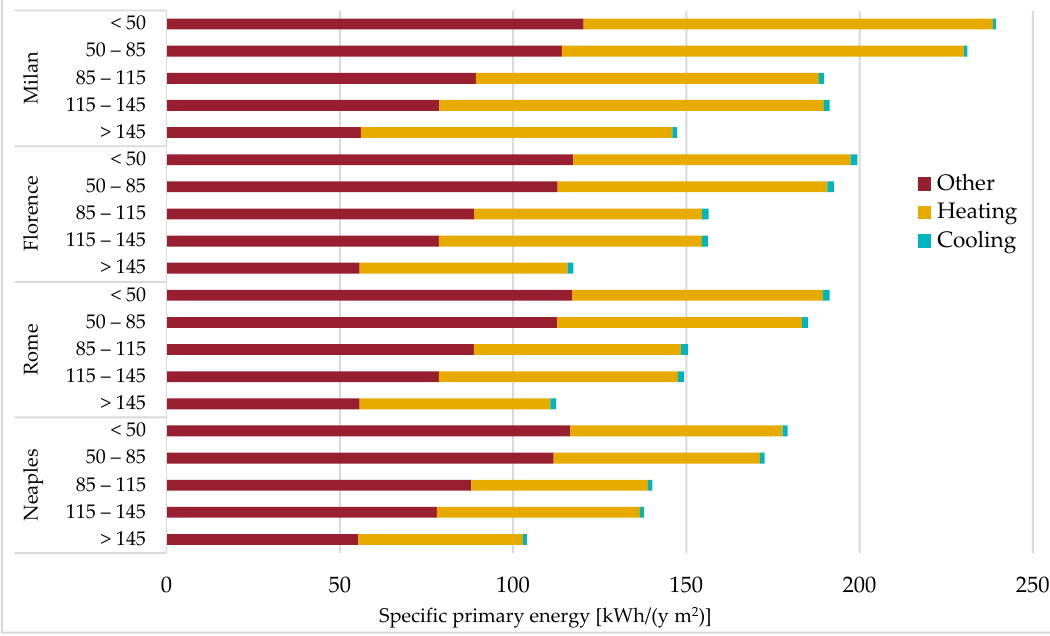
Figure 9. Specific primary energy consumption for heating, cooling, and other.